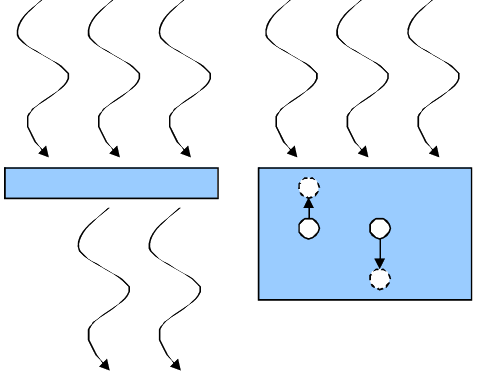
Figure 16. Schematic for the trade-off issue in photovoltaic layer thickness. Thinner photovoltaic layers will have less light absorption (left) while thicker layers will have more bulk carrier recombination